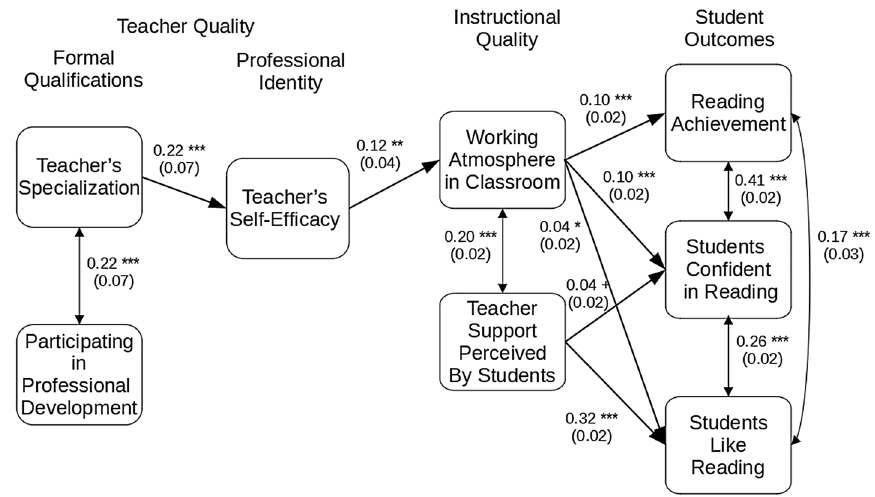
Fig. 5 Path analysis model for Norway